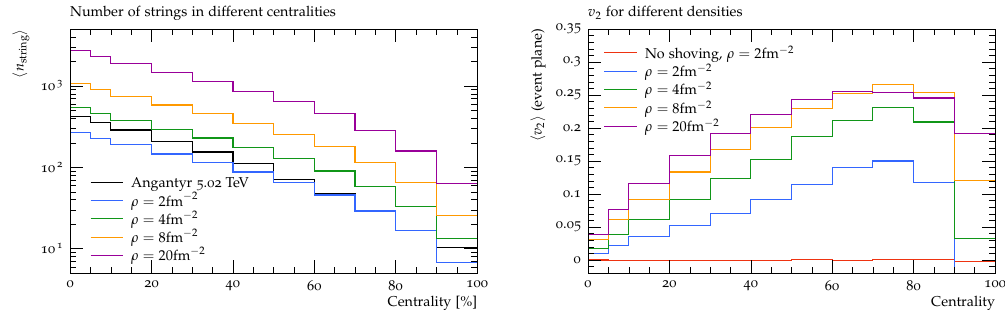
Figure 8 . The number of string pieces (left) and v 2 (right) as function of centrality in the Pb-Pb toy model, for different values of ρ . In (right) compared to the number of strings generated by Angantyr around mid-rapidity for Pb-Pb collisions at